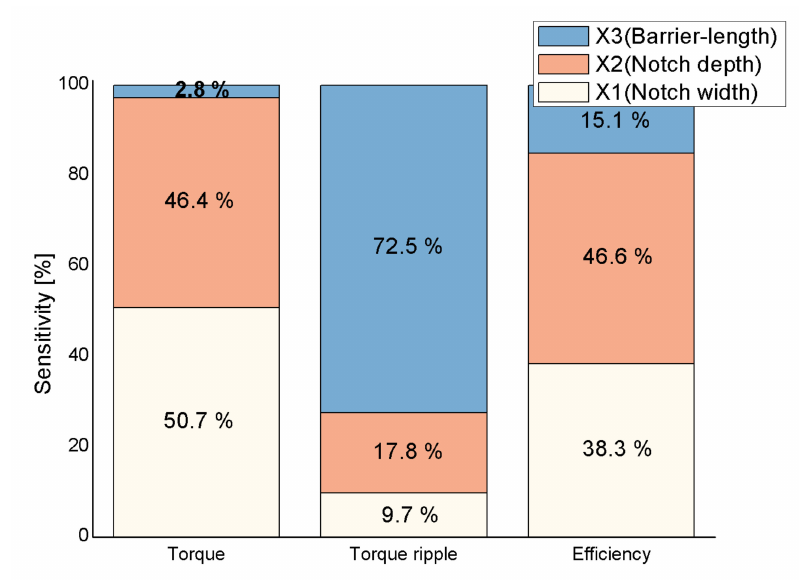
Figure 5. Sensitivity analysis using the screening